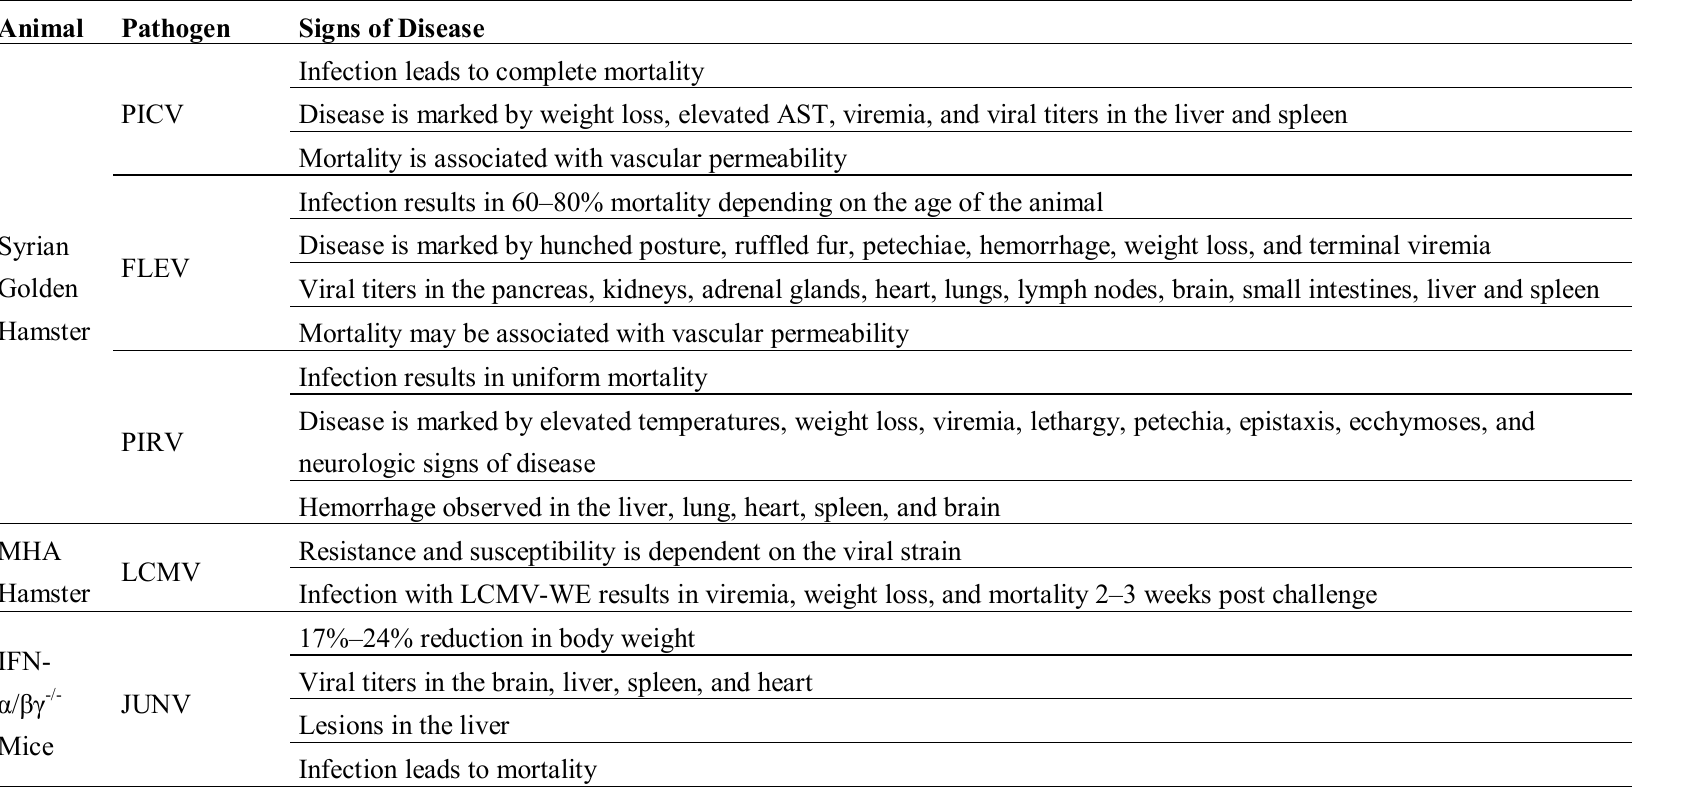
Table 2. Arenavirus—Syrian Golden Hamster and Mouse